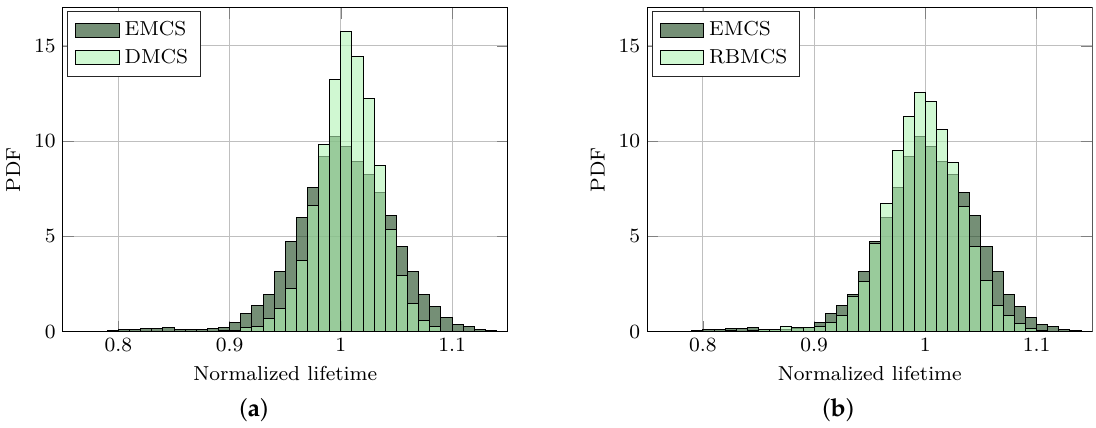
Figure 7. Illustrative assessment of the performance of the two improved sampling concepts for turbine H05: normalized lifetime PDF (normalized with the mean lifetime using 3 years of data ( µ 3years ) for reasons of confidentiality). ( a ) Lifetime PDF for J Σ = 2800 and EMCS compared to DMCS. ( b ) Lifetime PDF for J Σ = 2800 and EMCS compared to